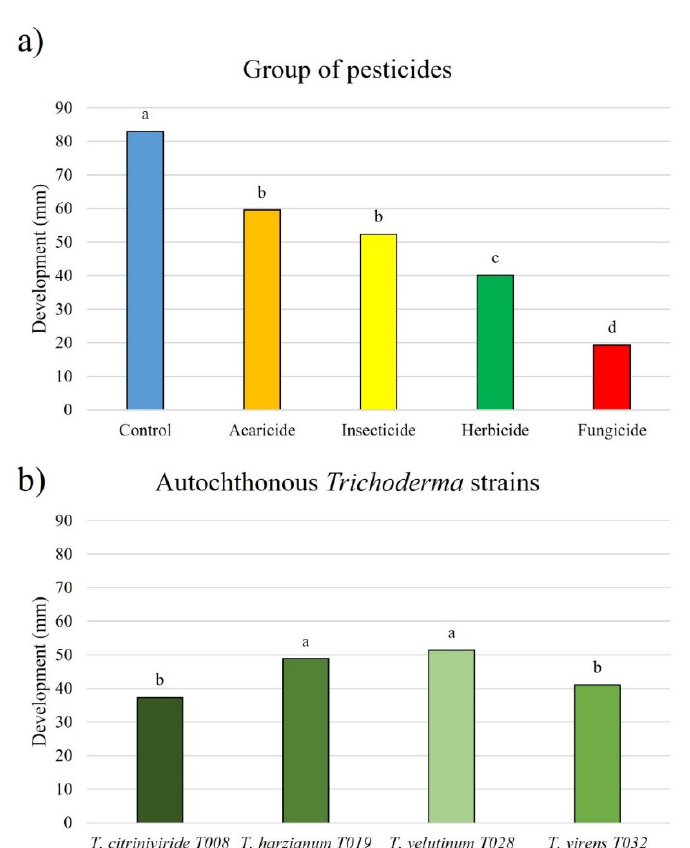
Figure 10. Development of autochthonous Trichoderma strains (diameter of growth, mm). ( a ) Ana- lyzing the groups of pesticides. Blue color: PDA medium. Orange color: acaricide. Yellow color: insecticide. Green color: herbicide. Red color: fungicide. ( b ) Autochthonous Trichoderma strains ( T. citrinoviride T008, T. harzianum T019, T. velutinum T028, T. virens T032). Different letters indicate sig- nificant differences between synthetic herbicides (ANOVA, LSD, p < 0.05).